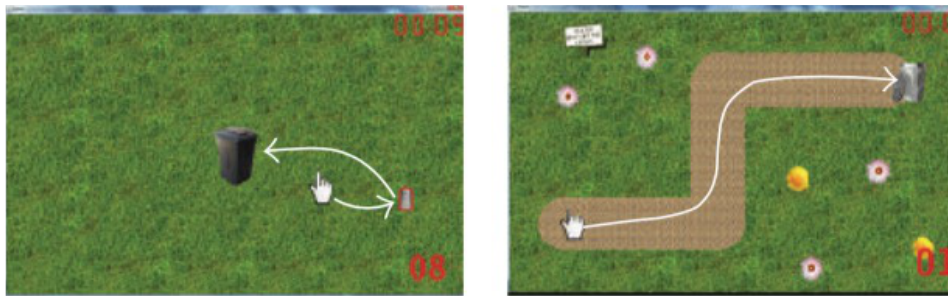
Fig. 1. Screenshots of the games used in the study by Popović et al.